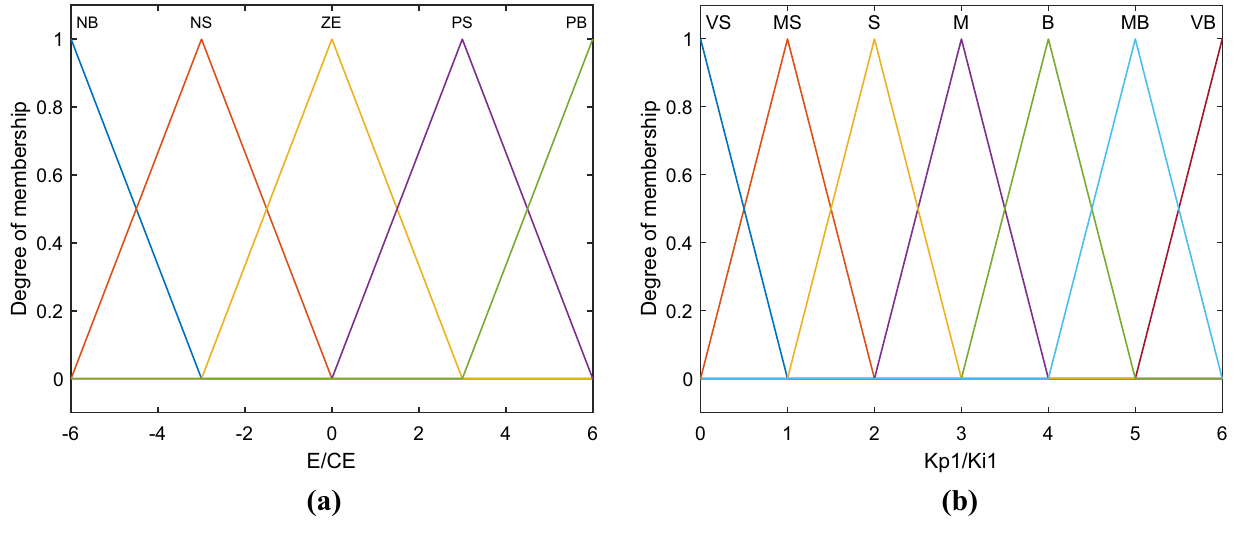
Fig. 3 Membership functions for a E/CE, b K